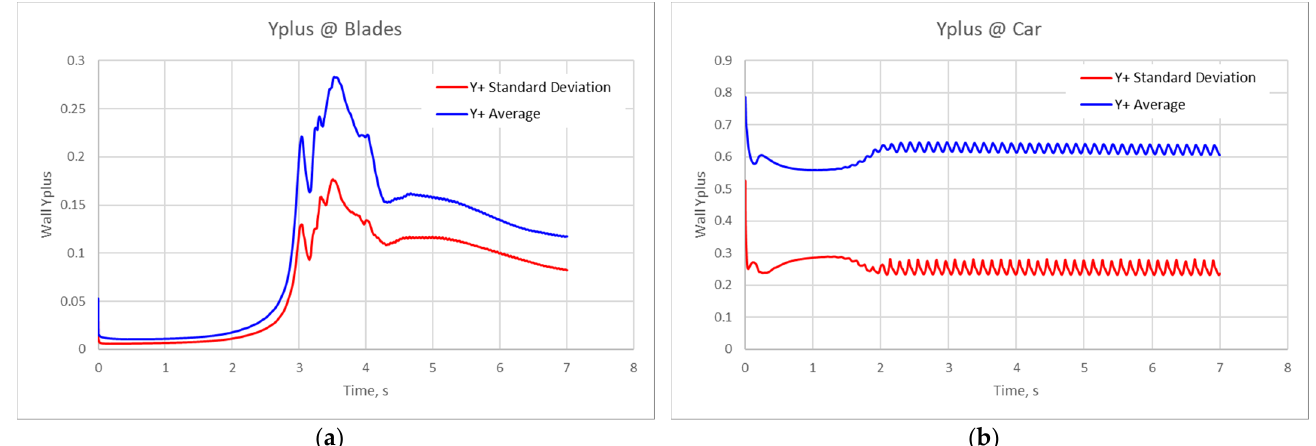
Figure 9. Wall y+ taken from medium mesh ( a ) at blade walls, ( b ) at car walls. Figure 9. Wall y + taken from medium mesh ( a ) at blade walls, ( b ) at car walls. For the confirmation of domain size, a velocity contour taken at t = 7 s using